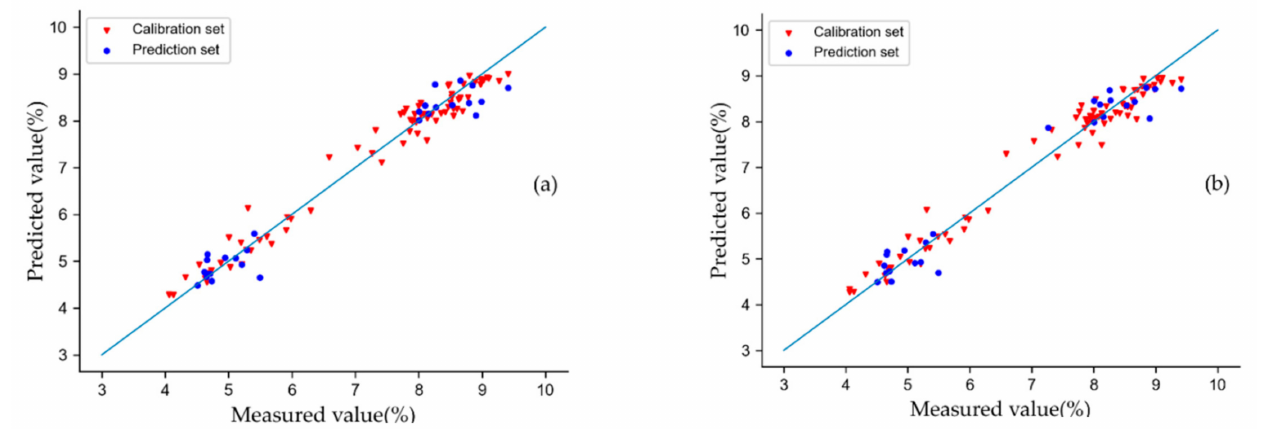
Figure 7. Prediction results of tea polyphenols based on CatBoost + Stacking model, “%” indicates the percentage of tea polyphenols in the dry matter of tea sample. ( a ) The modeling results before replacing the samples. ( b ) The modeling results after replacing the